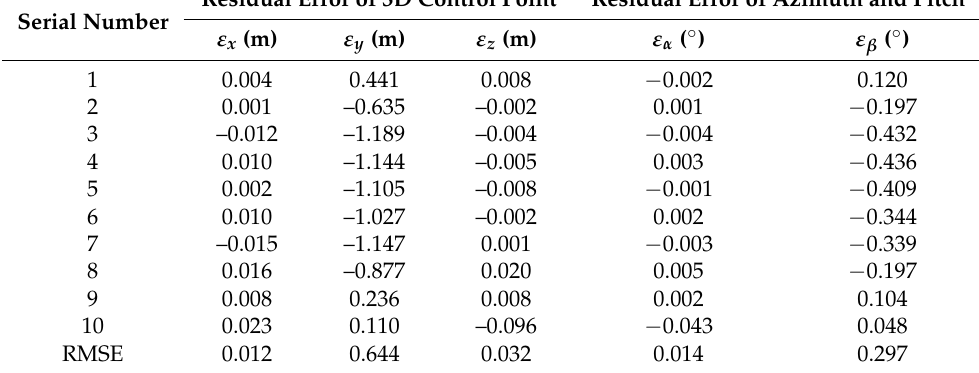
Table 4. Location and attitude errors.